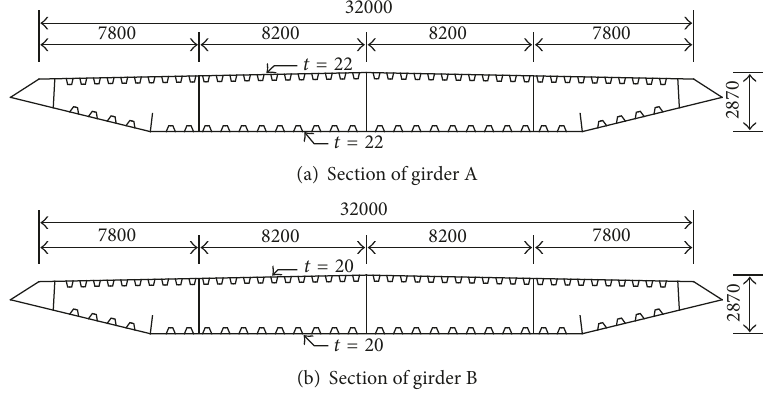
Figure 2: Section of the girder (unit: